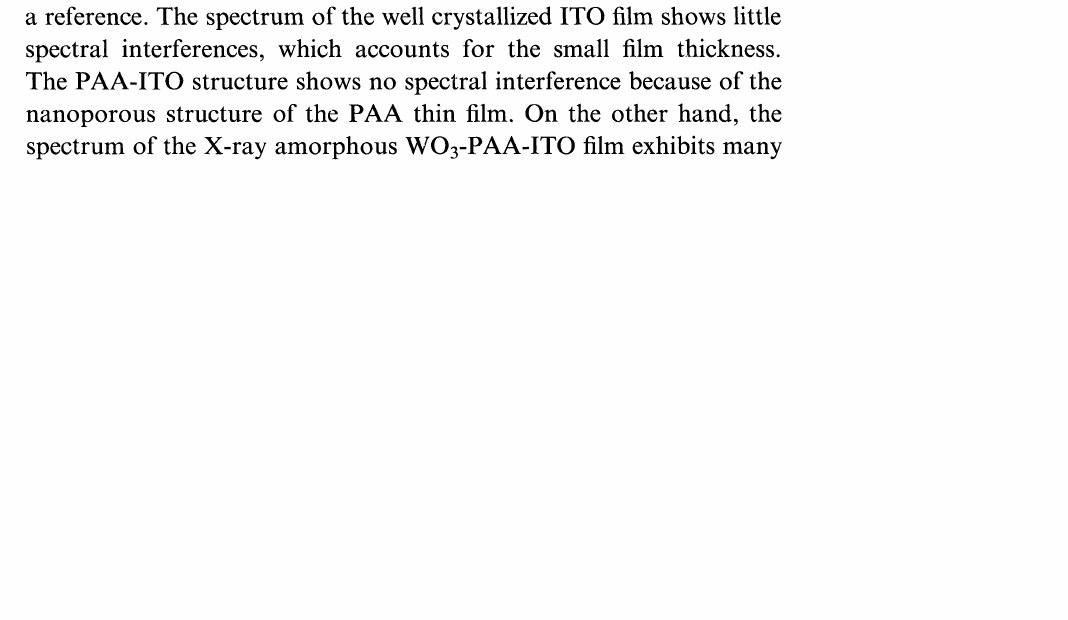
FIGURE 3 E(V) f(t) cycling diagram of the cell with Pt/LiTFSI + 1, 3-EtMelm TFSI WO3-PAA-ITO during 0 to 20 cycles (top) and 80 to 100 cycles (bottom), where each cathodic and anodic process is carried out at constant current of 0.5 mA for 150 sec (corresponding to Q= 12.5